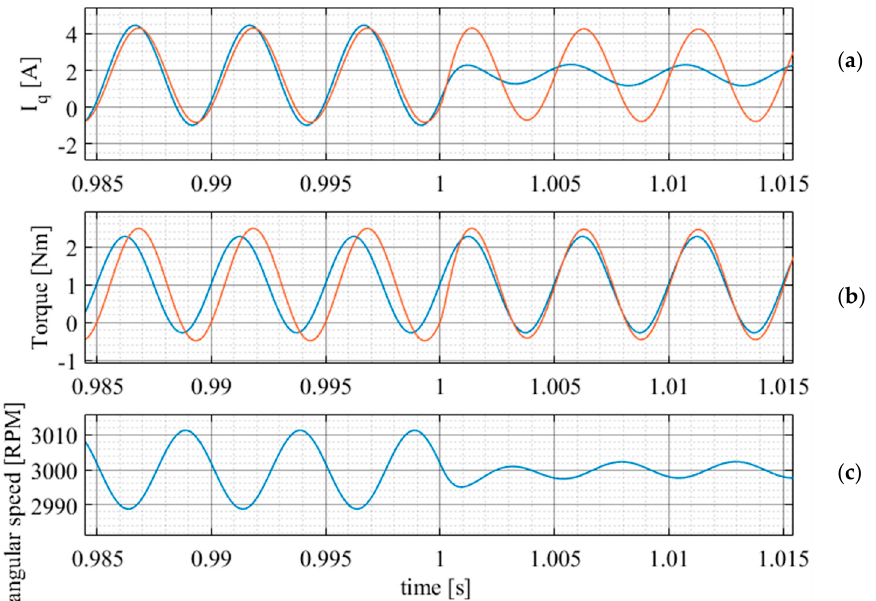
Figure 6. Total torque measured and electromagnetic one with compensation t osc. ( a ) i q measured (orange) and i q generated by speed controller (blue); ( b ) load torque course (blue) and electromagnetic one (orange); ( c ) rotating angular speed.